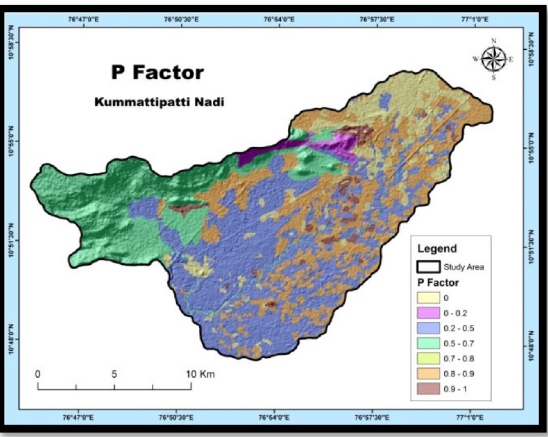
Figure 8. Annual average soil